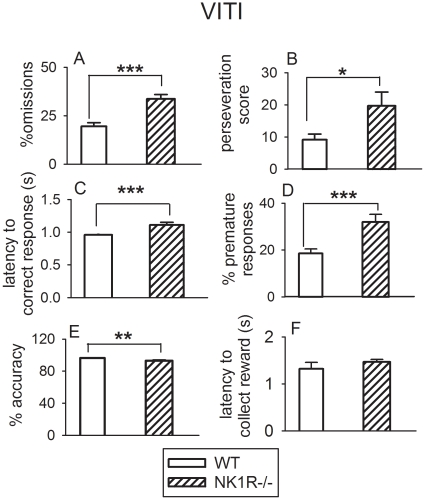
The performance of wildtype and NK1R-/- mice tested with a variable ITI (‘VITI’) in the 5-CSRTT.NK1R-/- mice show greater % omissions (A), perseveration score (B) latency to correct response (C), % premature responses (D) but lower % accuracy (E) than wildtypes and no difference in latency to collect the reward (F), regardless of time of day, when tested with a variable inter-trial interval (VITI). Bars show mean ± s.e.m for each behavioral score. * P<0.05, ** P<0.01, *** P<0.001 for differences between group means. N = 23–24 per group.